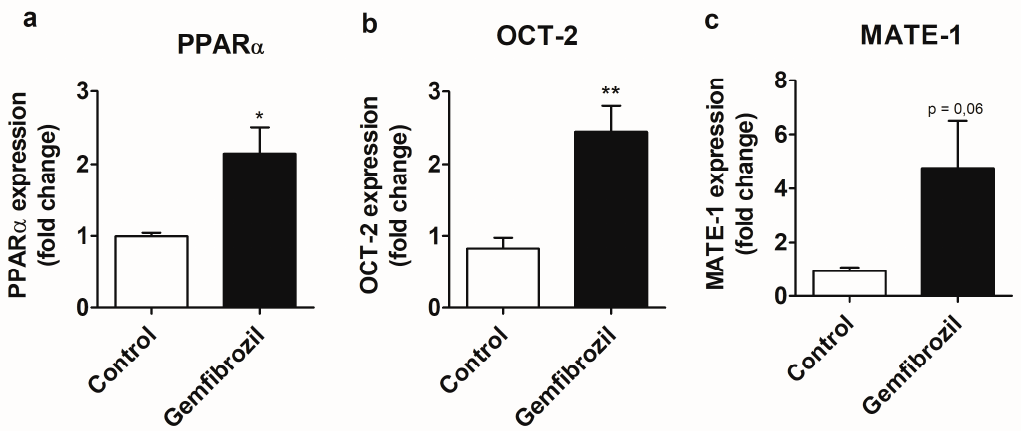
Figure 3. Modulation of PPAR α ( a ), OCT-2 ( b ), and MATE-1 ( c ) expression by gemfibrozil (100 µM). Cells were incubated for 24 h with the compounds. Data was compared by the unpaired, nonparametric Mann-Whitney test, * p < 0.05, ** p < 0.01. Data is presented as Mean ± S.E.M.